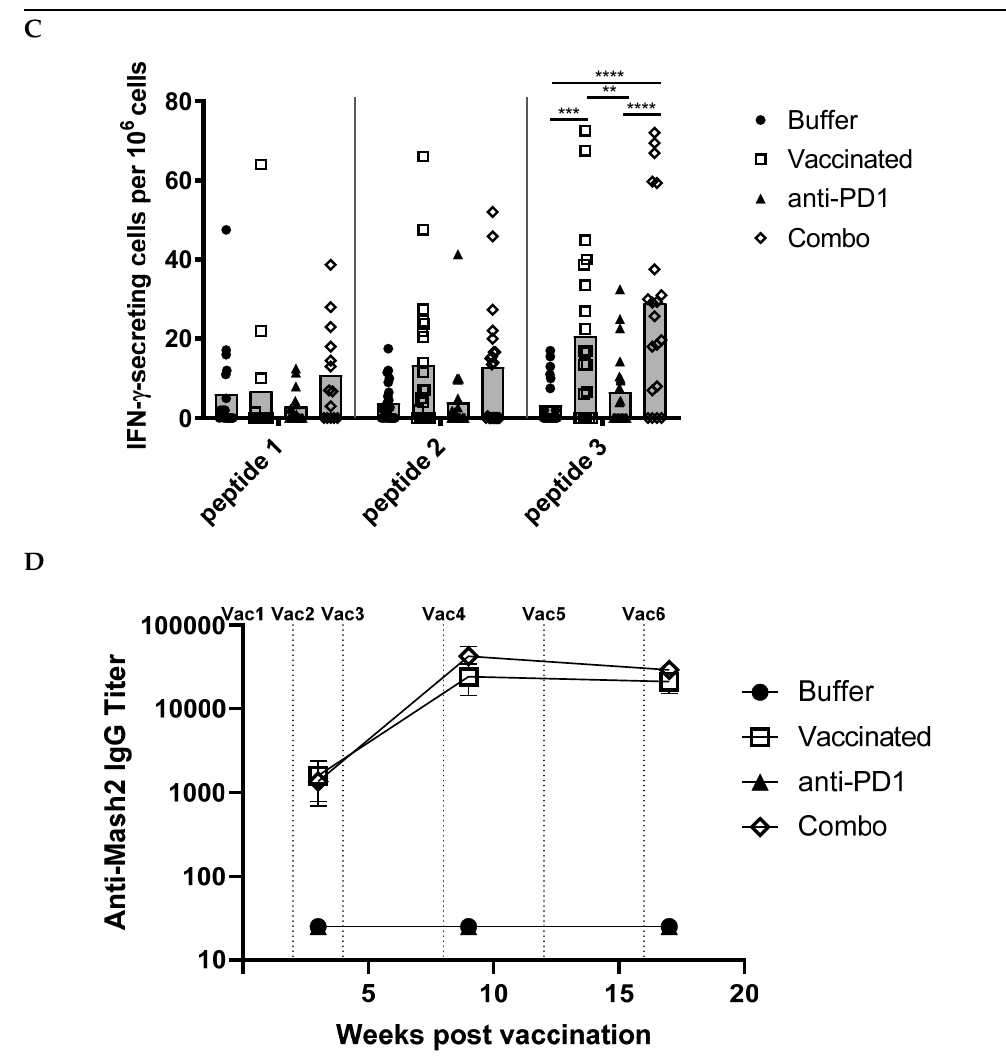
Figure 3. Combination of KISIMA-Mash2 vaccine and anti-PD-1 treatment is safe and promotes T cell immunity in Apc +/Min-FCCC mice. ( A ) Study design. Animals underwent colonoscopy (cross) prior to enrollment on study. Serum was collected (triangles) at baseline and at three additional intervals throughout the study. Vaccine or vehicle control (arrows) was administered six times, and anti-PD1 or buffer control (stars) was administered in three cycles of three-weekly injections. All animals were necropsied one week after the last vaccine injection. ( B ) Average body weight of animals obtained weekly for the duration of the study. ( C ) T cell immune response assessed by ELISpot on ex vivo splenocytes after overnight stimulation with overlapping peptide pools derived from Mash2 antigen. Bar represents the mean of each group for each peptide pool stimulation. ** p < 0.01; *** p < 0.001; **** p < 0.0001 (2-way ANOVA followed by Tukey’s multiple comparison) ( D ) Humoral response determined in serum at Week 3, Week 9, and Week 17 by detecting anti-KISIMA-Mash2 IgG by ELISA. Line represents the mean for each group. p < 0.05 between Vaccinated vs. Control or Anti-PD-1 groups and p < 0.001 between Combo vs. Control or Anti-PD-1 groups at Week 17 (Two-way ANOVA followed by Tukey’s multiple comparison). Remarkably, high antibody response against Mash2 was observed in Apc +/Min-FCCC mice vaccinated with KISIMA-Mash2 alone (Figure 3D) with a peak of antibody response reached after 4 vaccinations. No further benefit was gained from the addition of anti-PD-1. No specific antibody response was detected in Apc +/Min-FCCC mice treated with vehicle or anti-PD-1